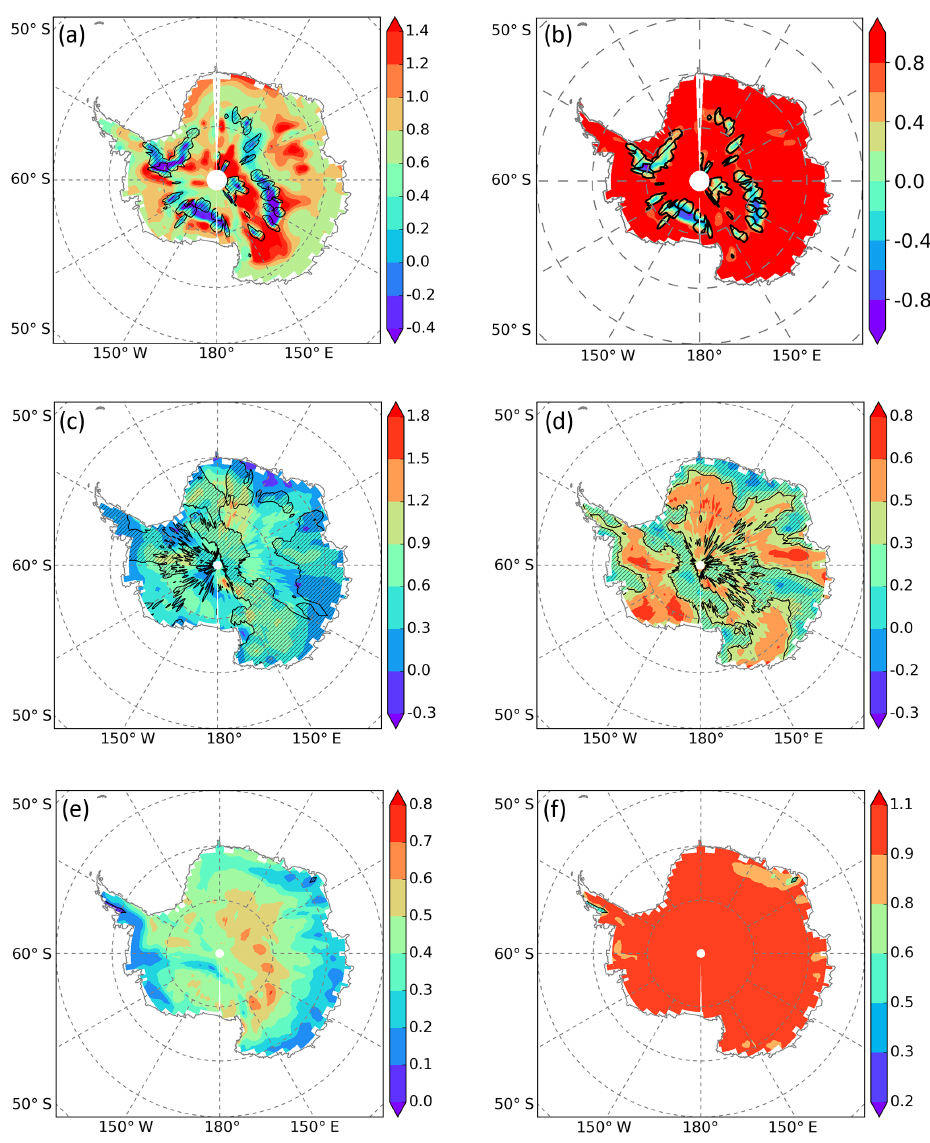
Figure 9. Linear analysis of annual ECHAM5-wiso outputs from 1979–2013 for the temporal δ 18 O–temperature relationship (using the 2m temperature and the precipitation-weighted δ 18 O). Maps show the slope of the linear regression (‰ ◦ C − 1 ) at the right side (a, c, e) and the correlation coefficient at the left side (b, d, f) . The upper plots use outputs at the spatial scale (a, b) , the middle plots at the inter-annual scale (c, d) , and the lower plots at the seasonal scale (e, f) . Areas where the results of the linear analysis are not significant are hatched ( p value >